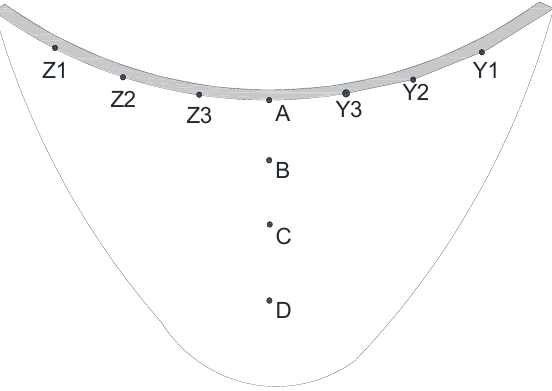
Figure 2. Distribution of monitoring points on the body of the arch